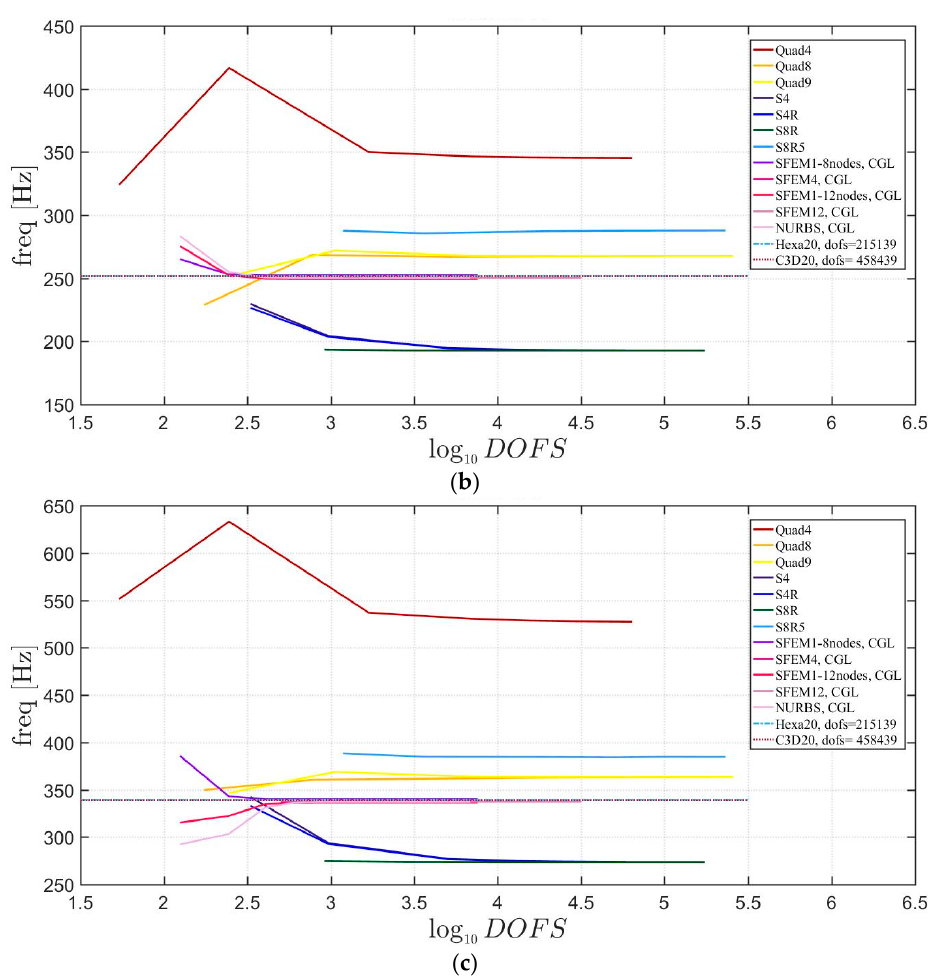
Figure 21. First three natural frequencies of a circular plate with a not-symmetric lamination scheme and a / h = 10: ( a ) First frequency; ( b ) Second frequency; ( c ) Third frequency.